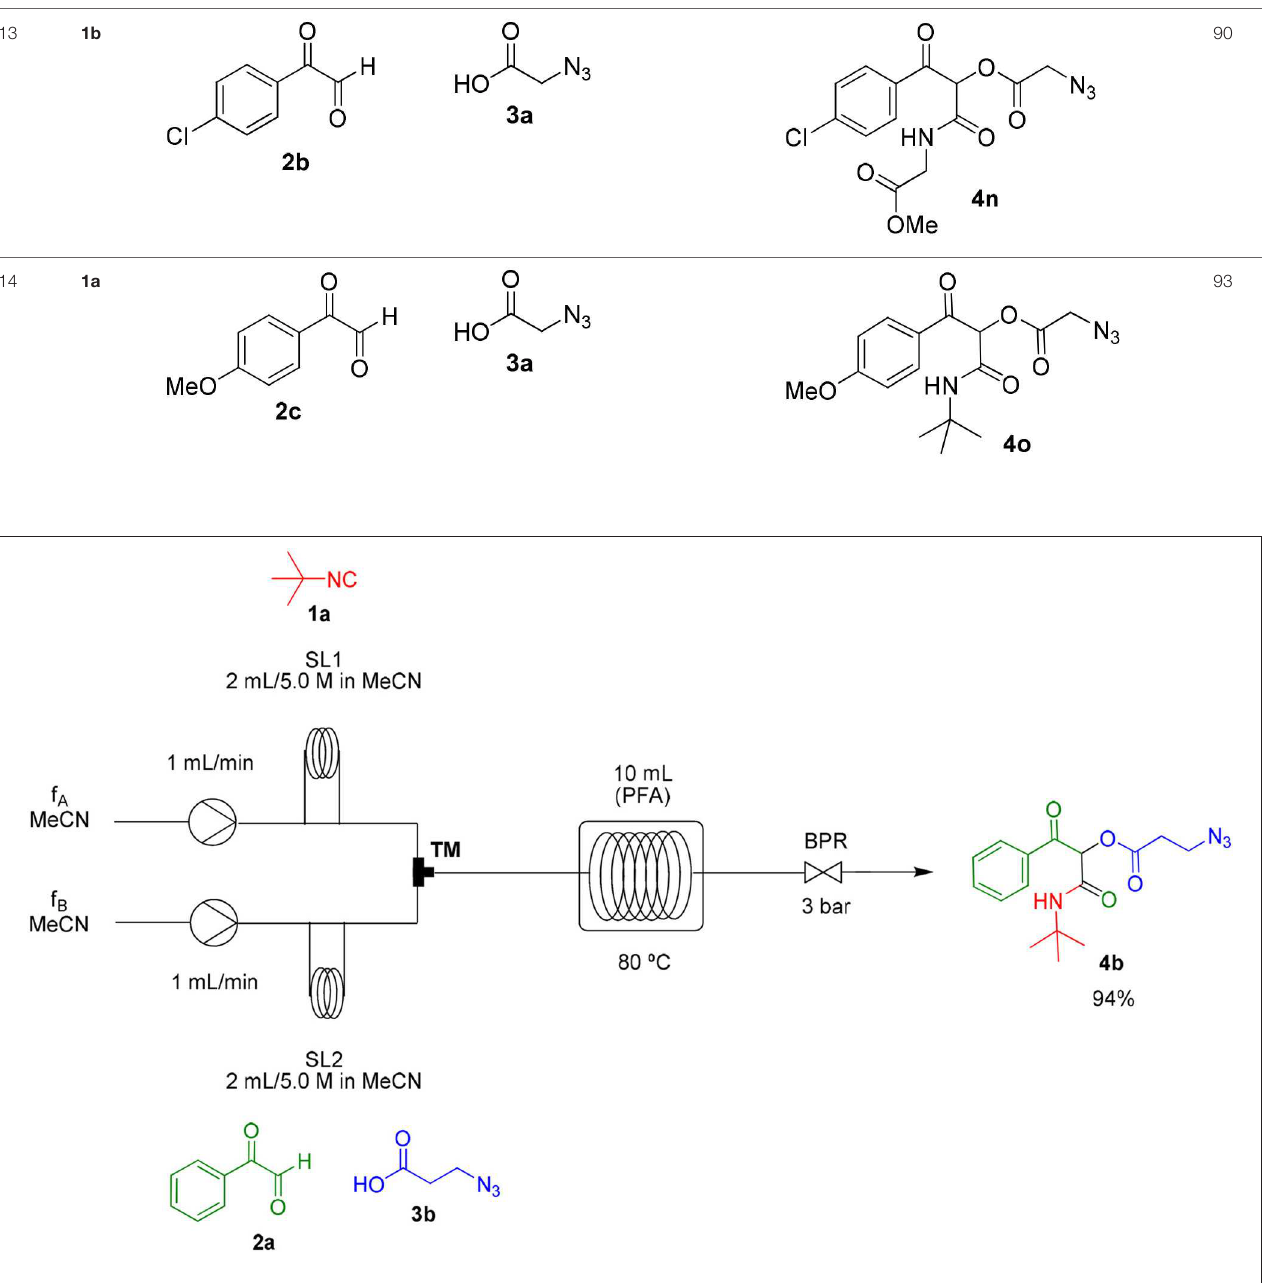
1-( Tert -Butylamino)-1,3-Dioxo-3- Phenylpropan-2-yl-2-Azidoacetate (4a) Very viscous yellow oil (0.146 g, 92% yield); HRMS (ESI): m/z: calcd for C 15 H 18 N 4 O 4 Na [M + Na + ]: 341.1220, found: